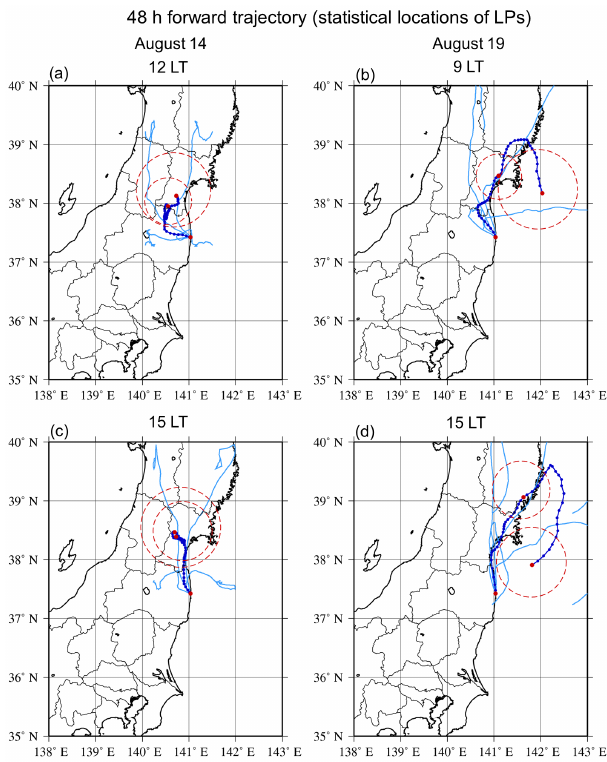
Figure 13. 48h forward trajectory (statistical locations of LPs within 1km AGL) predicted by the LM starting at (a) 12:00LT and (c) 15:00LT on 14 August and (b) 09:00LT and (d) 15:00LT on 19 August. Blue lines indicate median locations of LPs at 1h and 1-day intervals as blue and red dots, respectively. Sky-blue lines indicate 17th and 83rd percentile locations of LPs and red dashed circles indicate areas containing 66% of the LPs.